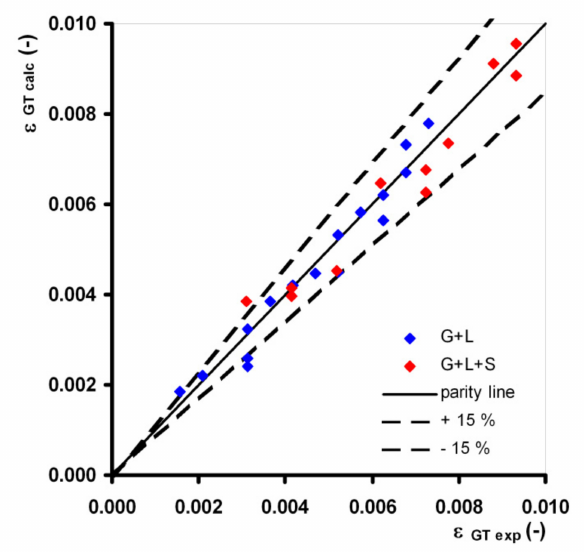
Figure 3. Total gas holdup α GT : Comparison of experimental and calculated data using (4)—parity plot.